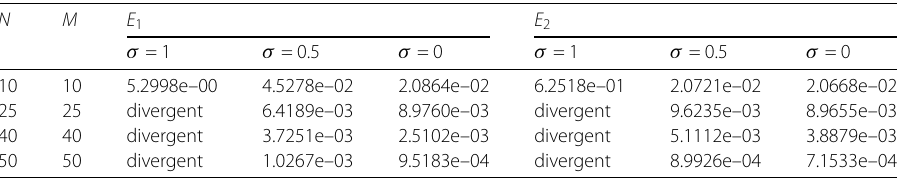
Table 3 Comparison of E 1 and E 2 , the maximum absolute errors, for different values of N , M in Example